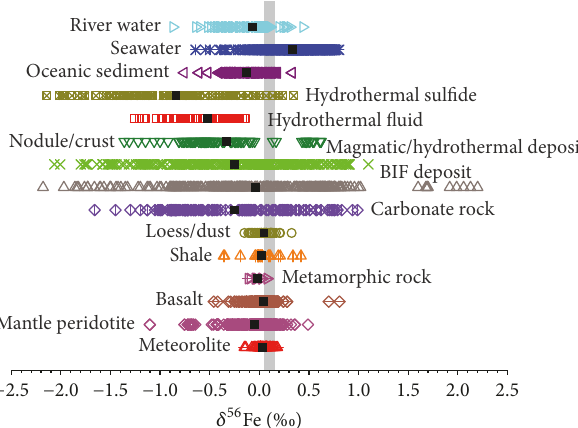
Figure 1: Fe isotopic composition of each repository. (The gray color column shows the Fe isotope composition of basalt with an average value of + 0.105 ± 0.006 ‰ ( 𝑛 = 43 ) [10]; the black rectangle shows the average value of 𝛿 56 Fe. All data from the literatures: river